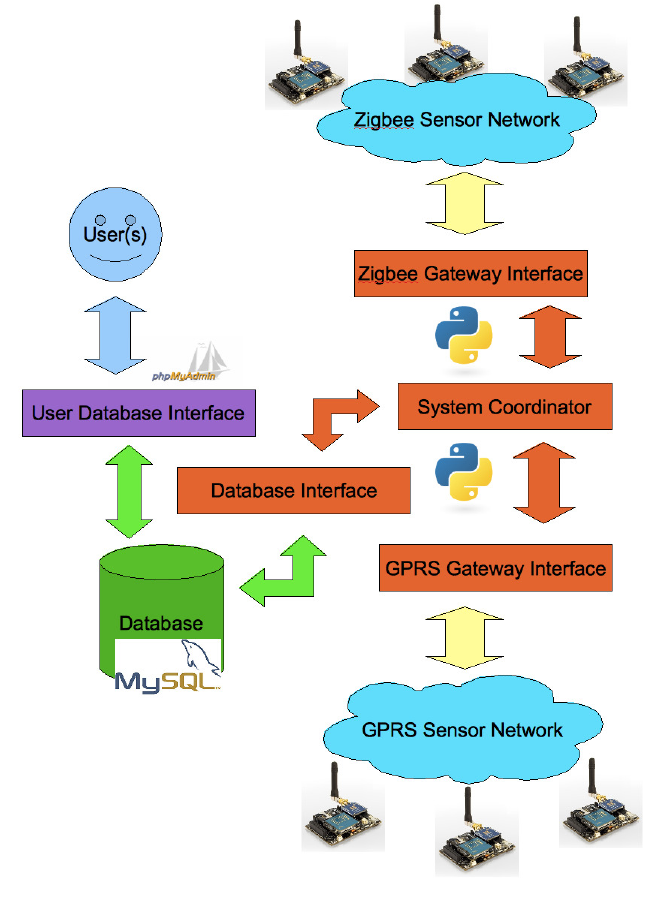
Figure 3. The WaspNet Development